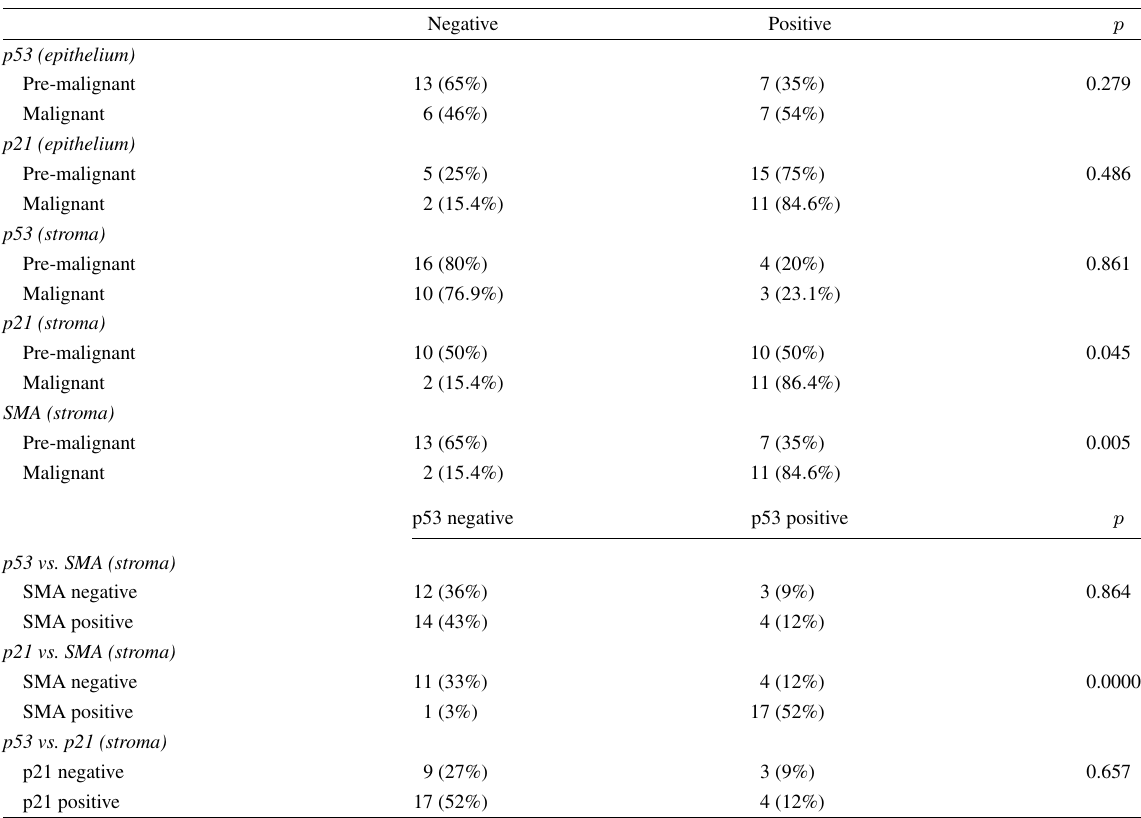
Immunohistochemical detection of p53, p21 and SMA in the stroma and the epithelium of oral cancers and pre-malignant